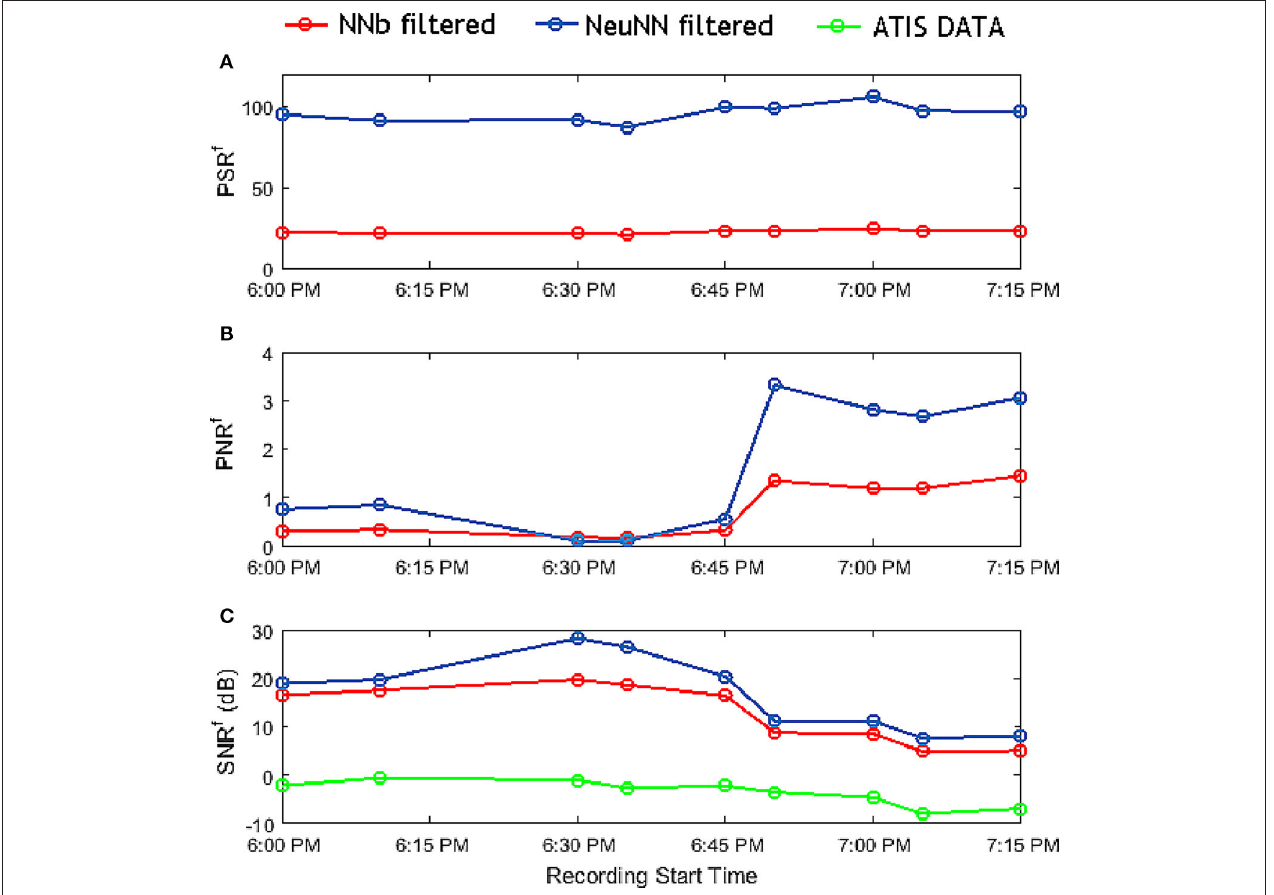
FIGURE 8 | Comparison of all the metrics of NNb filter and NeuNN filter with respect to each sample file at various recording times representing varying background noise characteristics.